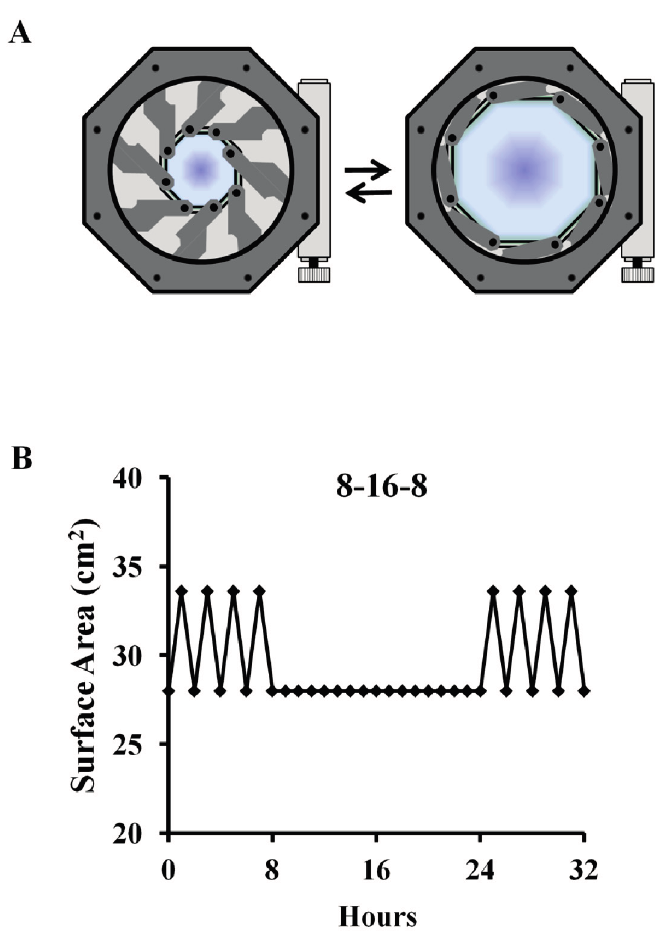
Figure 1. Cell stretching device and stretch protocol. Schematic representation of mechanical stretching device ( A ) used to apply low-frequency high-magnitude strains; ( B ) Graphical representation of the 8–16–8 and stretch protocol applied to primary